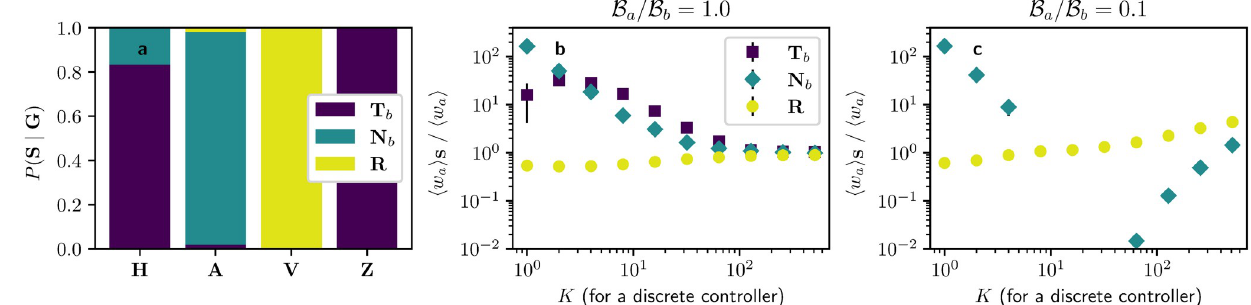
Fig 4. Analysis of the shielding heuristic on optimal influence allocations in the continuous regime. a Overlap between the allocation groups in G and shielding groups in S for a passive controller targeting K = 16 nodes in a discrete fashion. b, c Average allocations given to each group in S with respect to the total average allocation h w i for different number of nodes K targeted by the passive controller and for b equal budgets or c budget disadvantage. Error ai bars in b, c represent standard errors calculated from 15 repeats of the experiment. Points for N b in the interval K 2 [5, 35] do not appear in c since their value is h w i ¼ 0 and the scale is logarithmic. The total budget of both controllers sums up to B a N b